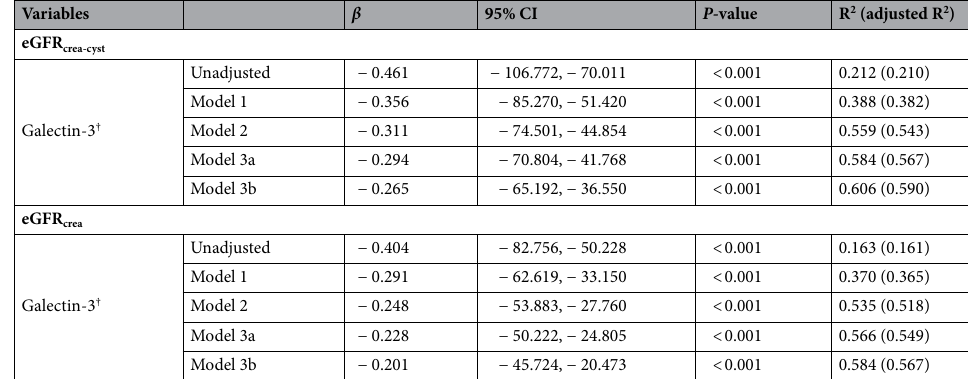
Table 4. Multiple linear regression analyses on eGFR in all patients with T2DM. A1C glycated hemoglobin, β Standardized regression coefficient, BMI body mass index, CI confidence interval, eGFR estimated glomerular filtration rate, Hgb hemoglogin, OHA oral hypoglycemic agent, T2DM type 2 diabetes mellitus, UACR urinary albumin-to-creatinine ratio. † Data were logarithmically transformed before analysis. Model 1: adjusted for sex and age. Model 2: adjusted for BMI, smoking, duration of diabetes † , A1C, Hgb, hyperlipidemia, hypertension, and use of insulin and OHAs, in addition to the variables in Model 1. Model 3a: adjusted for all confounders in Model 2 plus UACR as albuminuria status (yes/no). Model 3b: adjusted for all confounders in Model 2 plus UACR as a continuous variable †